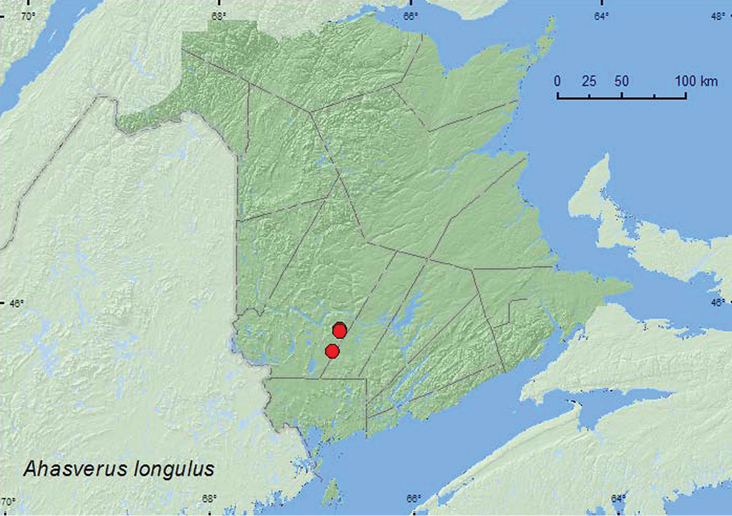
Collection localities in New Brunswick, Canada of Ahasverus longulus.